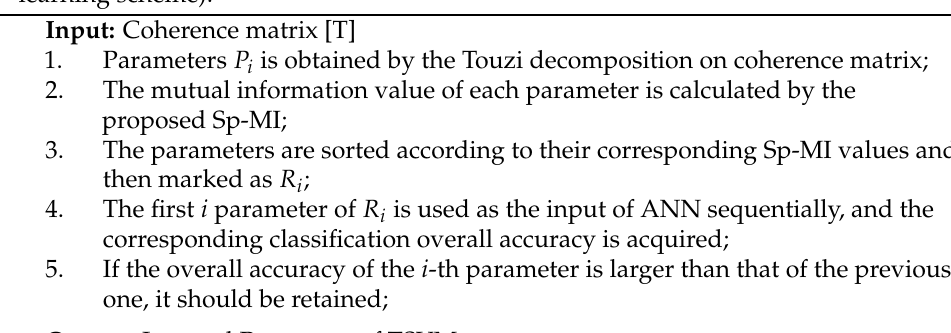
Algorithm 1: Representative Learning Scheme (The proposed representative learning